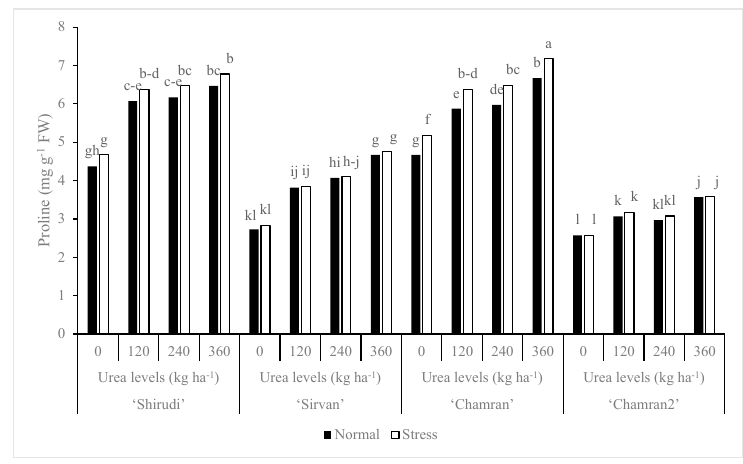
Fig. 1 Interaction effects of location, irrigation, cultivar, and urea levels on the free proline concentrations. Mean values with the same letters are not significantly different at p ≤ 0.05 according to Duncan’s test.